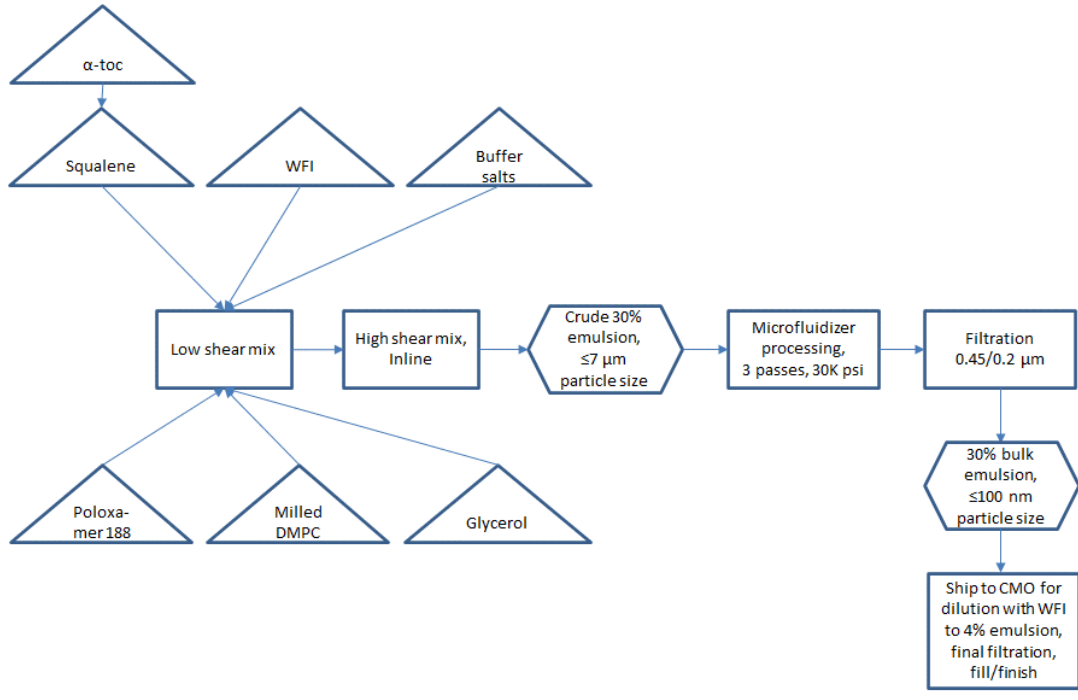
Figure 6. Large-scale (200 L) process flow diagram for one-pot production of SE.